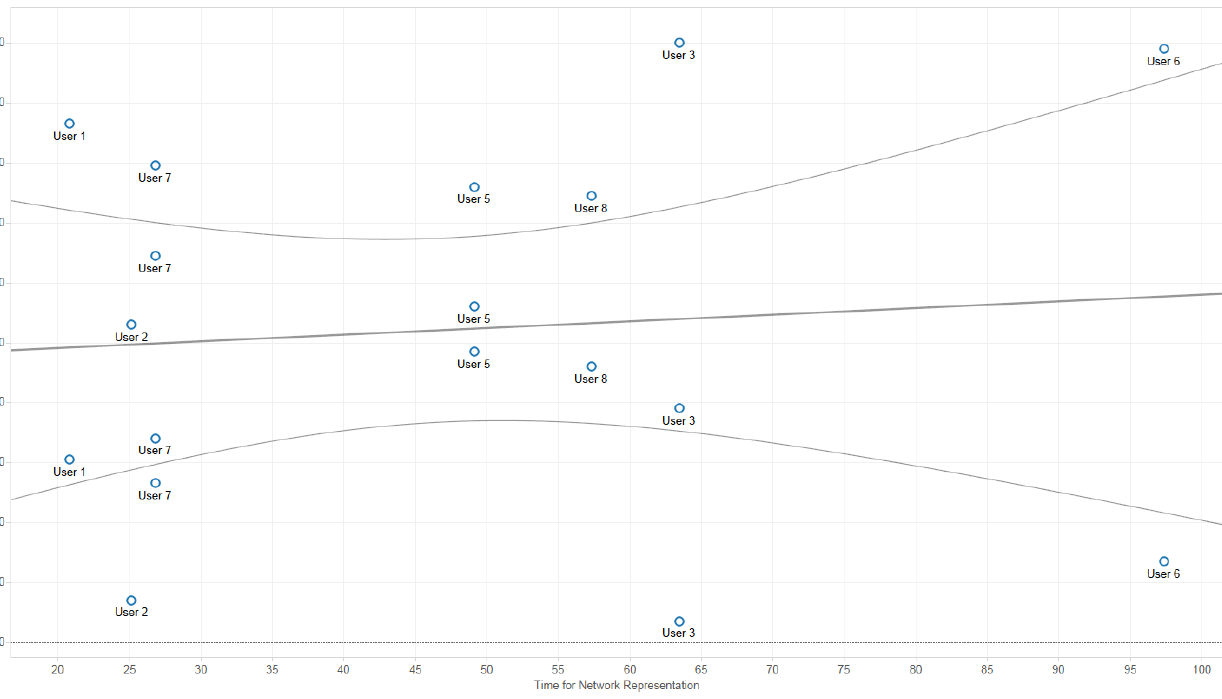
Figure 12. Relationship between the time spent on network representation questions and the time it took for users to answer the other questions. R-squared for this linear model is